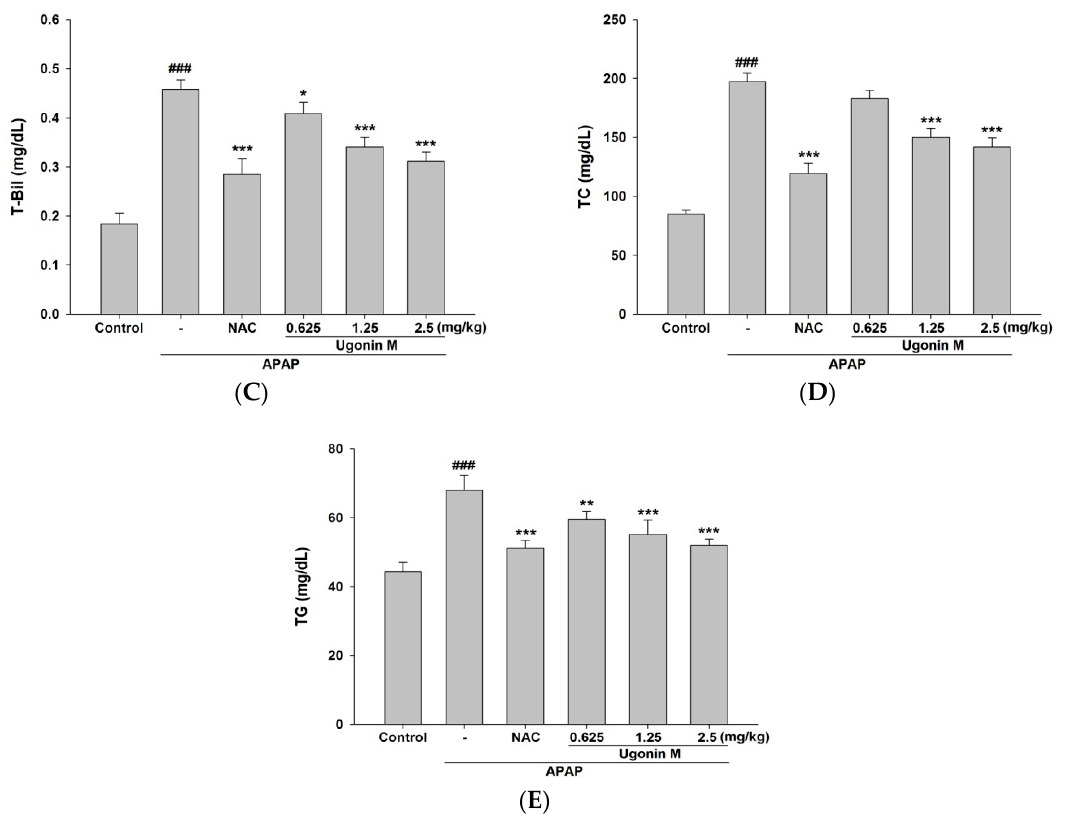
Figure 3. Effects of Ugonin M on serum ( A ) aspartate aminotransferase (AST), ( B ) alanine aminotransferase (ALT), ( C ) total bilirubin (T-Bil), ( D ) total cholesterol (TC), and ( E ) triglyceride (TG). Data are expressed as mean M ± SD; n = 6.